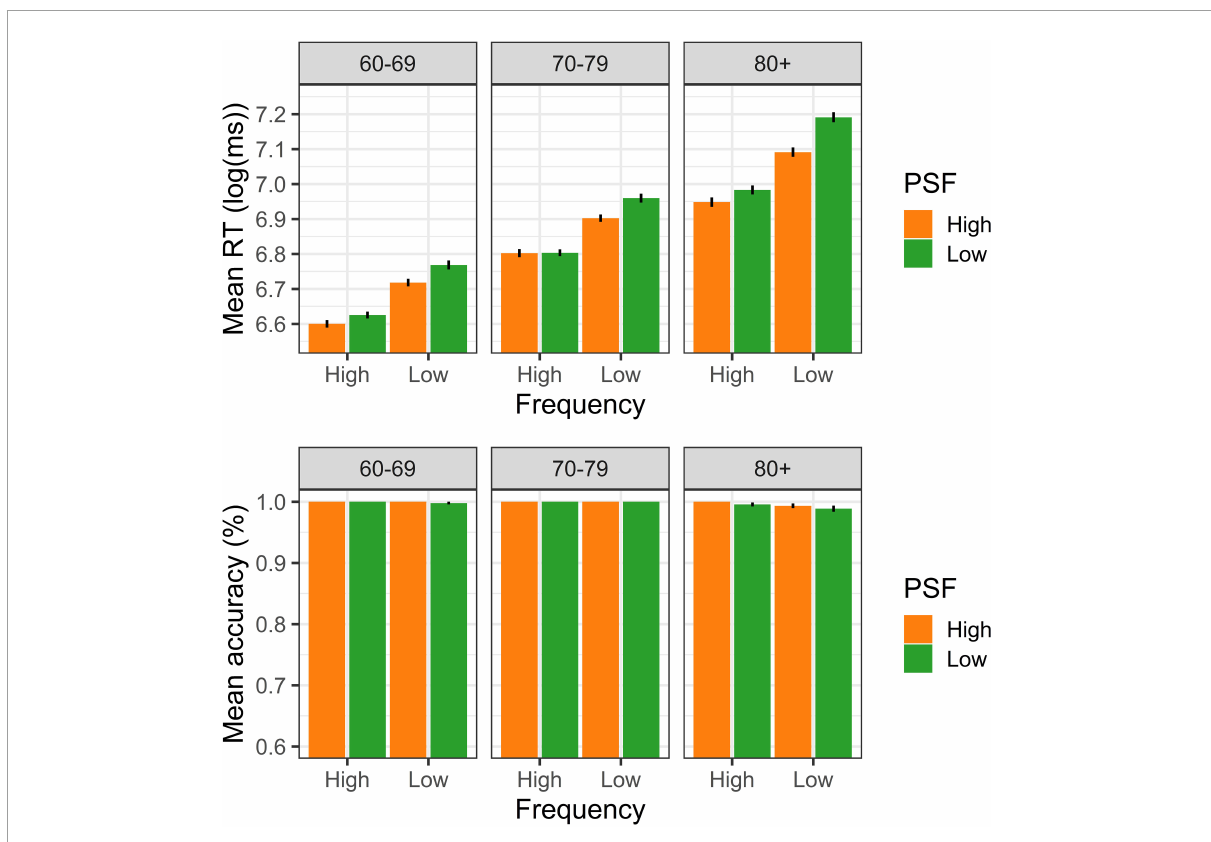
FIGURE1 Word response pattern on RT (log) and accuracy in Experiment 1.